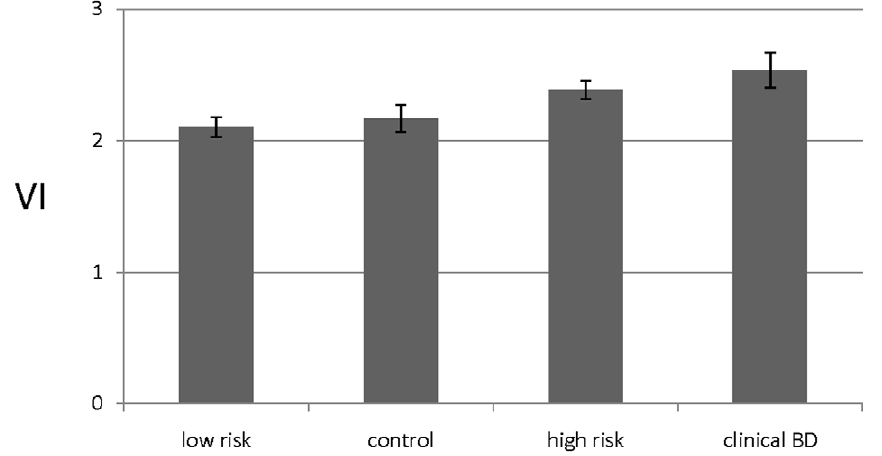
Figure 4. Estimated means ( ± SEM) computed vulnerabilityindex (VI) values in four groups of human subjects of increasing risk or presence of BD. Low risk by GBI criteria (n=35), healthy controls (n=15), high-risk by GBI criteria (n=35), and patients diagnosed with DSM-IV type- I BD who are currently clinically stable or euthymic (n=15). Curve-fitting found that mean VI increased linearly across these groups ( F [df=3; 94]=4.28, p =0.007, controlling for sex and